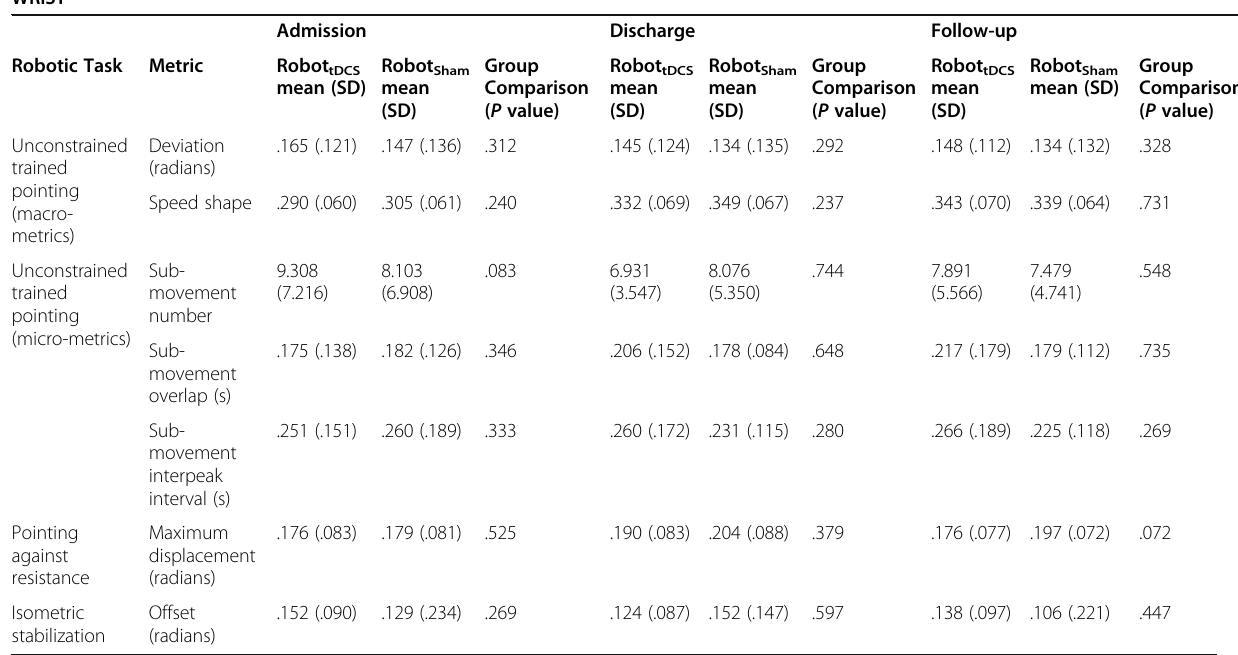
Table 3 Comparison of Robot tDCS and Robot Sham kinematic and kinetic metrics at admission, discharge, and follow-up for the